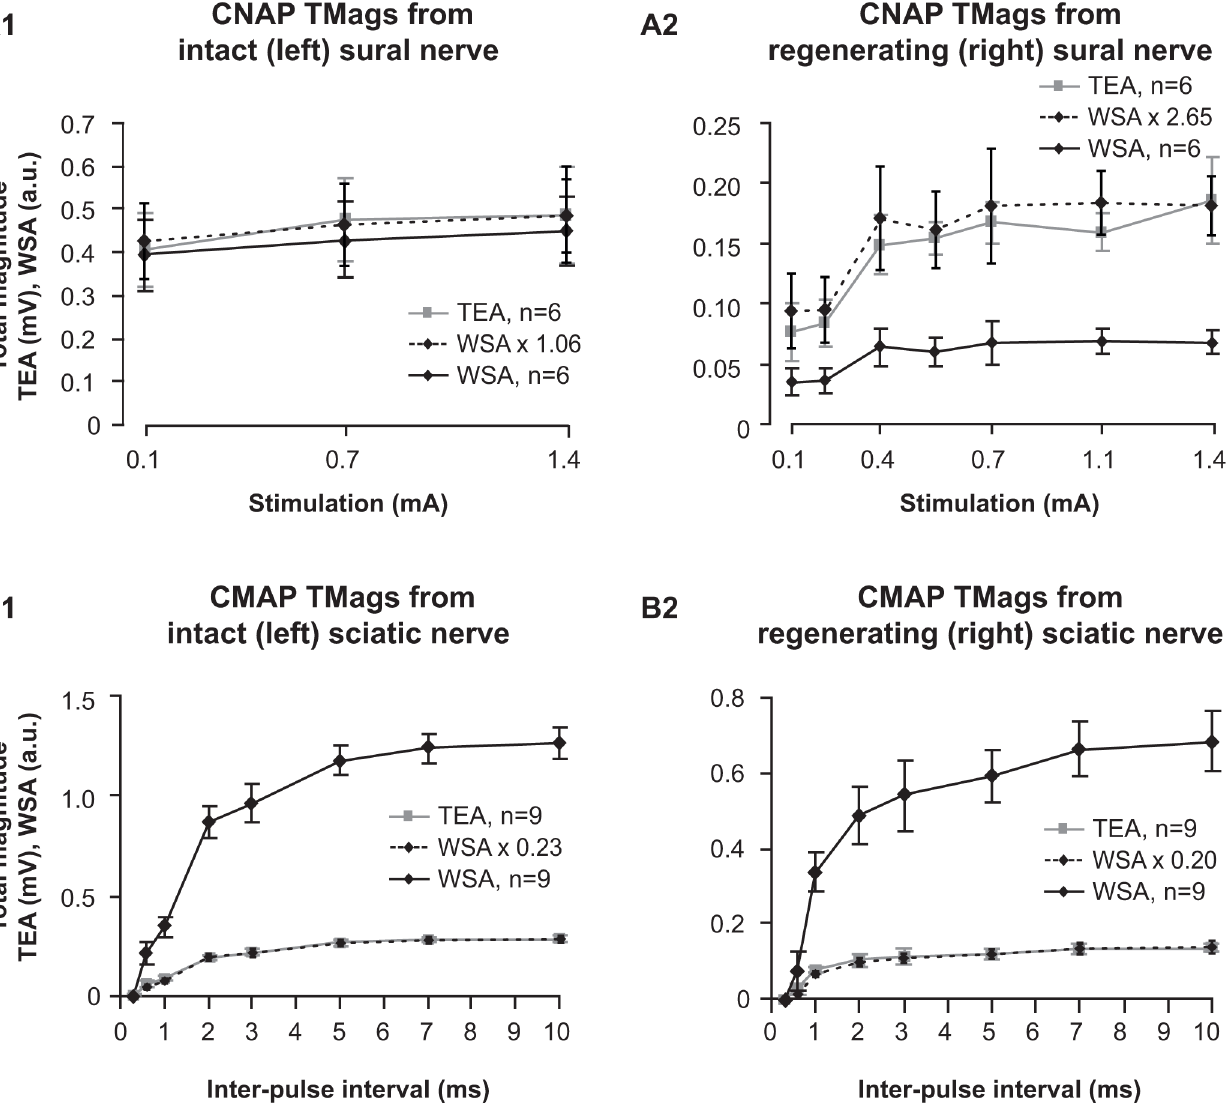
Fig 7. Magnitude profiles derived from WSA and TEA. N10avR total magnitudes (TMags) were calculated by quantifying and summing magnitudes of all events for each response of intact (A1) and regenerating (A2) sural nerves using WSA (black) and TEA (grey). TMags derived from WSA were amplitude- corrected (dashed) by multiplying the TMag WSA by a constant (indicated) derived from the ratio of [mean TMag TEA ]/[mean TMag WSA ] (see Materials and Methods) evoked from the strongest stimulus pulse (1.4 mA). Magnitude profiles were also derived from M5avR TMags for intact (B1) and regenerating (B2) nerves. Similarly, TMag WSA of M5avRs were amplitude-corrected (dashed) by multiplying by a constant (indicated) based on the ratio of mean total magnitudes with the greatest inter-pulse interval (10 ms).